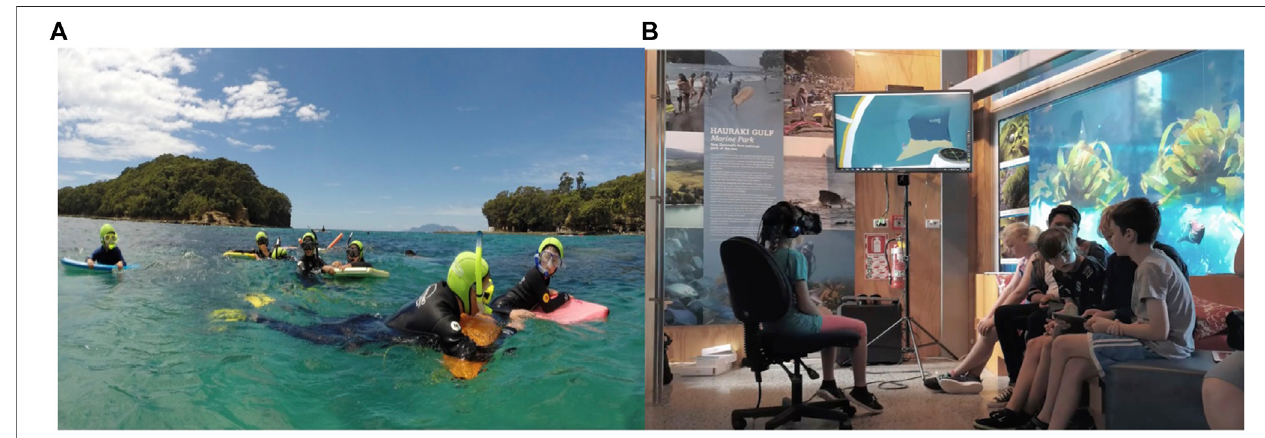
FIGURE 7 | (A) students experiencing the underwater world while taking part of a snorkel group tour; (B) Pipi ’ s World VR experience using a high-end (HTC Vive) setup, where children interact with pipi the young snapper fi sh telling the story of her protected marine environment (source: Aguayo and Eames,